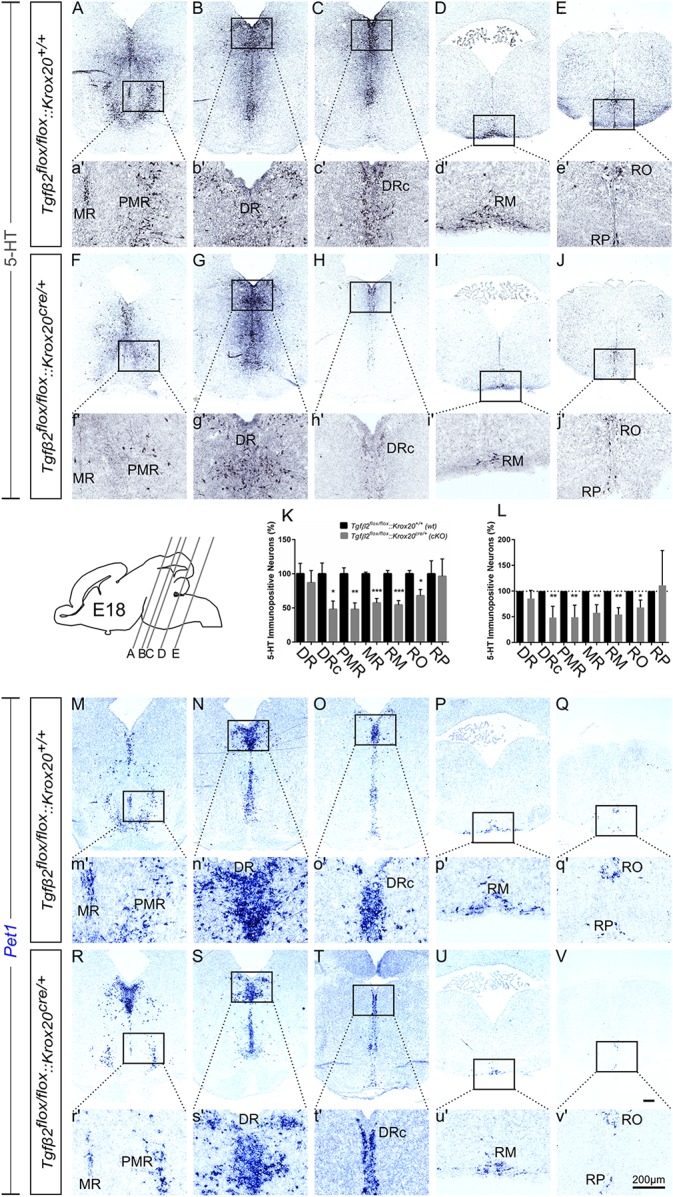
Phenotype analysis of Tgfβ2flox/flox:Krox20cre/+ hindbrain at embryonic day 18 (E18). Immunoperoxidase light microscopy for the rostral serotonergic neuron subgroups (5-HT positive) DR (B,G), caudal part of the dorsal raphe (DRc, C,H), median raphe (MR, A,F), and PMR (A,F), and of the caudal serotonergic neuron subgroups RM (D,I) and RO (E,J) of Tgfβ2flox/flox:Krox20+/+ (wt) and Tgfβ2flox/flox:Krox20cre/+ at E18. (a′–j′) Represent higher magnification of the respective black-boxed areas in (A–J). Counting of 5-HT-positive (K,L) cells after immunostaining in hindbrain fixed tissue sections revealed significant decrease in the number of DRc, PMR, MR, RM, and RO but not of DR nor RP serotonergic neuron subpopulations between in Tgfβ2flox/flox:Krox20cre/+ mutants, and wild type (wt) (∗p < 0.05 and ∗∗p < 0.01, using the unpaired two-tailed Student’s t-test n = 3–5). Data are given as mean ± SEM, the mean of wt was set to 100 (K) or the mean of wt littermate was set to 100 (L). (M–V) ISH for expression of the serotonergic marker Pet1. Lower case images (m′–v′) represent magnification of the black-boxed area of the respective upper case images. Scale bar: 200 μm.